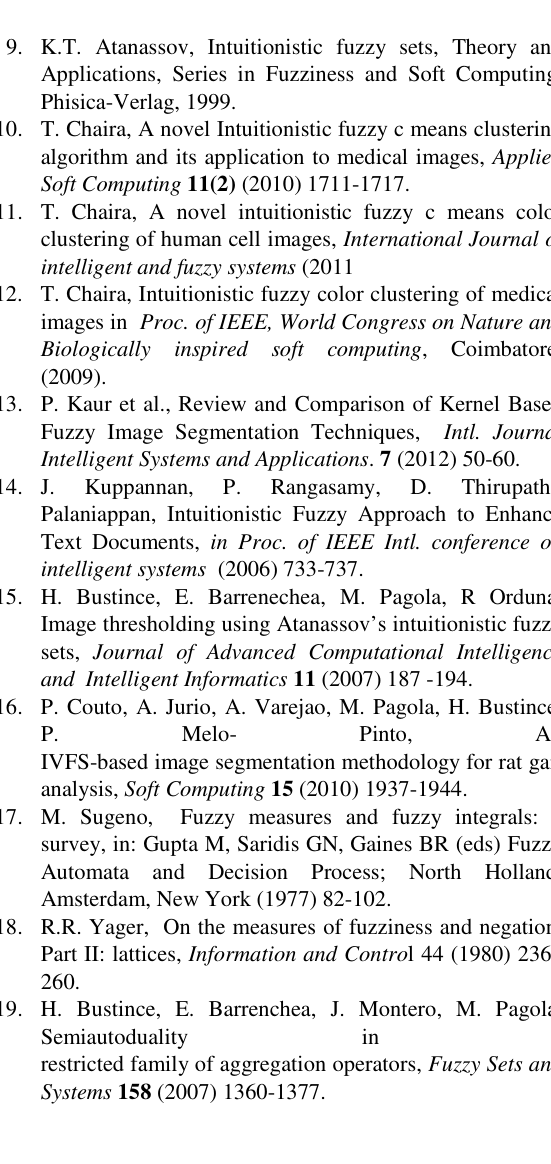
Table. 1: No. of iteration in different methods No. of iterations No. of clusters Standard FCM 30 3 IFCM 18 3 Kernel FCM 13 3 IFCM with 12 3 Gaussian kernel IFCM with 14 3 hyper tangent kernel IFCM with 12 radial basis kernel